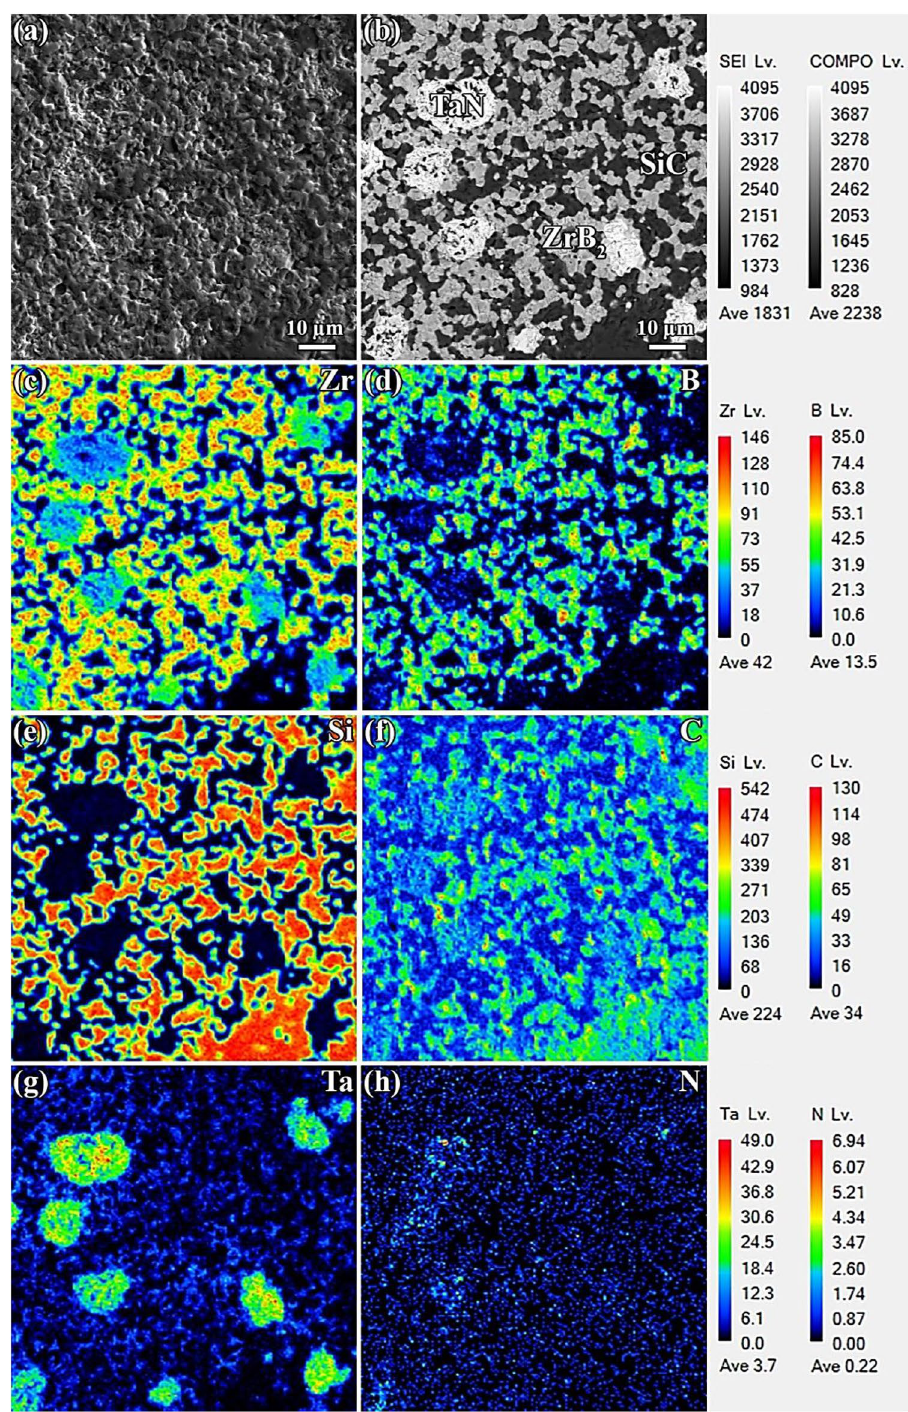
Figure 6. ( a and b ) FESEM images of polished surface of ZrB 2 -SiC-TaN, and ( c – h ) the corresponding EPMA